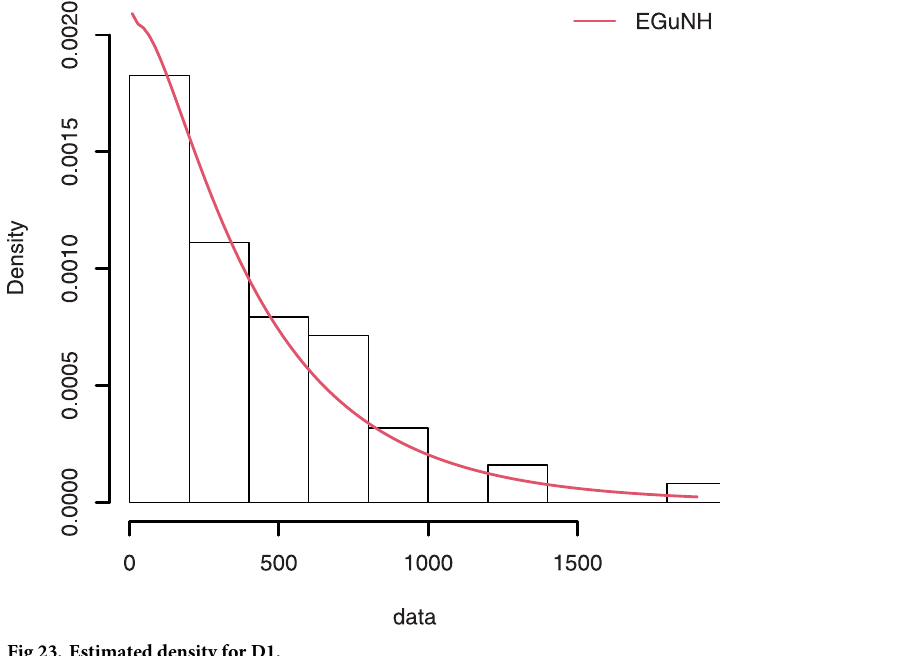
Fig 23. Estimated density for D1.